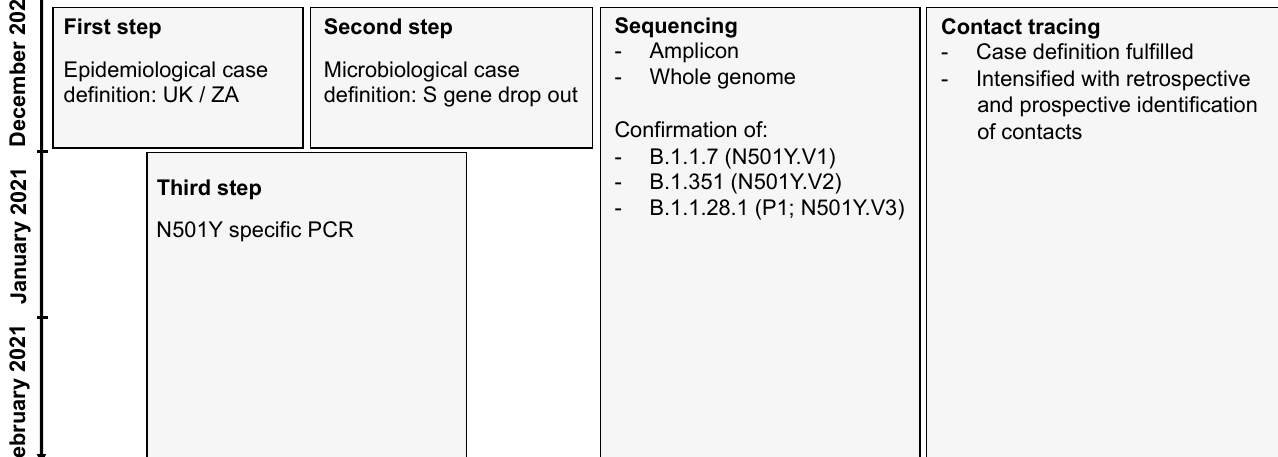
Figure 1. Diagnostic strategy to detect the B.1.1.7 and the B.1.351 in Switzerland. The flowchart shows the three-step strategy with (i) initial epidemiological case definitions with travels from the UK or South Africa, (ii) the diagnostic evidence due to a S gene dropout and (iii) the final establishment of a N501Y-specific PCR. In all steps amplicon based and whole genome sequencing was used to determine and confirm the lineage allocation.